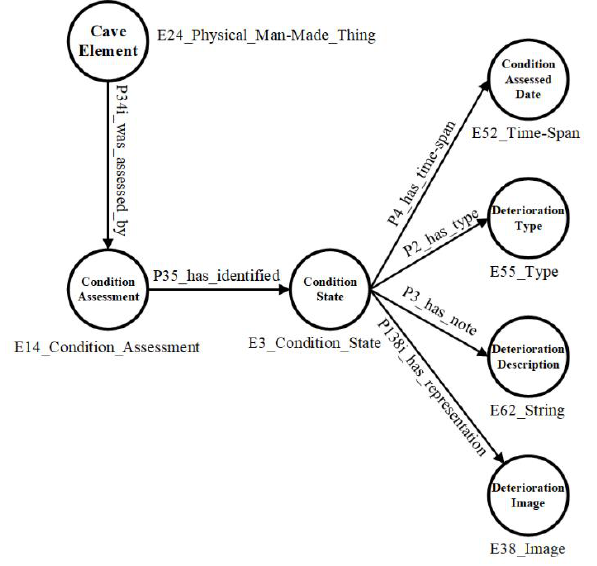
Figure 4. Example of condition assessment